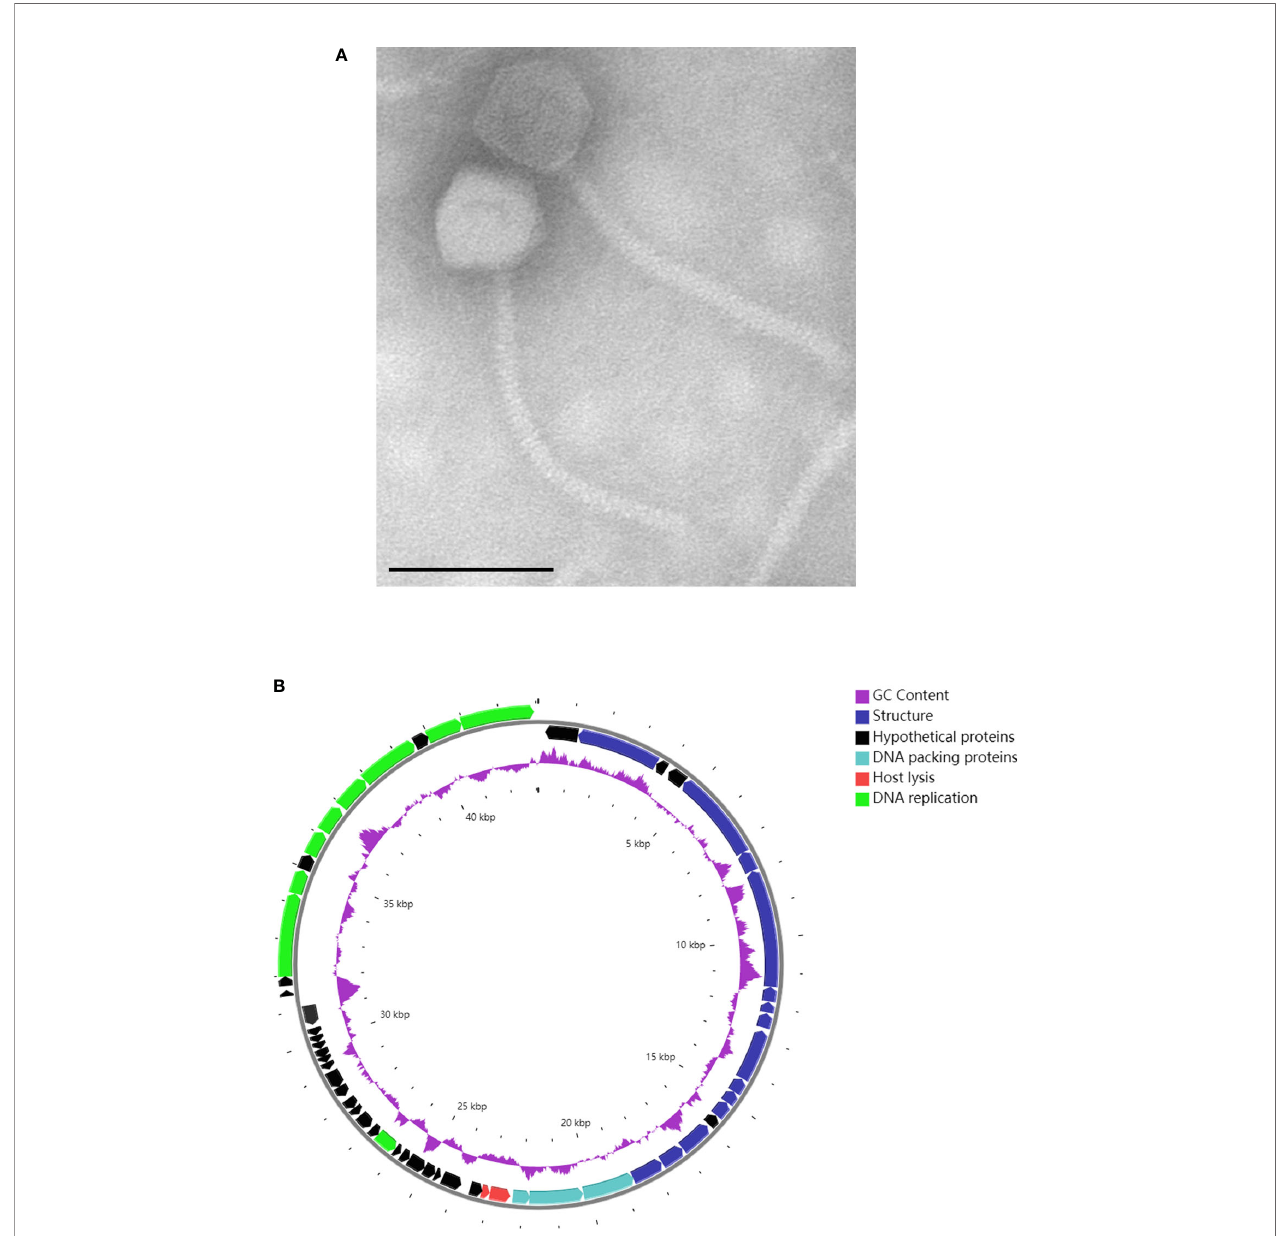
FIGURE 2 | Characterization of phage Ab_SZ3. (A) Transmission electron micrographs of the phage. Scale bar represents 100 nm. (B) Genome map of the phage. The color of the ORFs refers to fi ve modules: phage structure, blue; host lysis, red; DNA packaging, light blue; DNA replication, green; and hypothetical proteins, black. GC content,